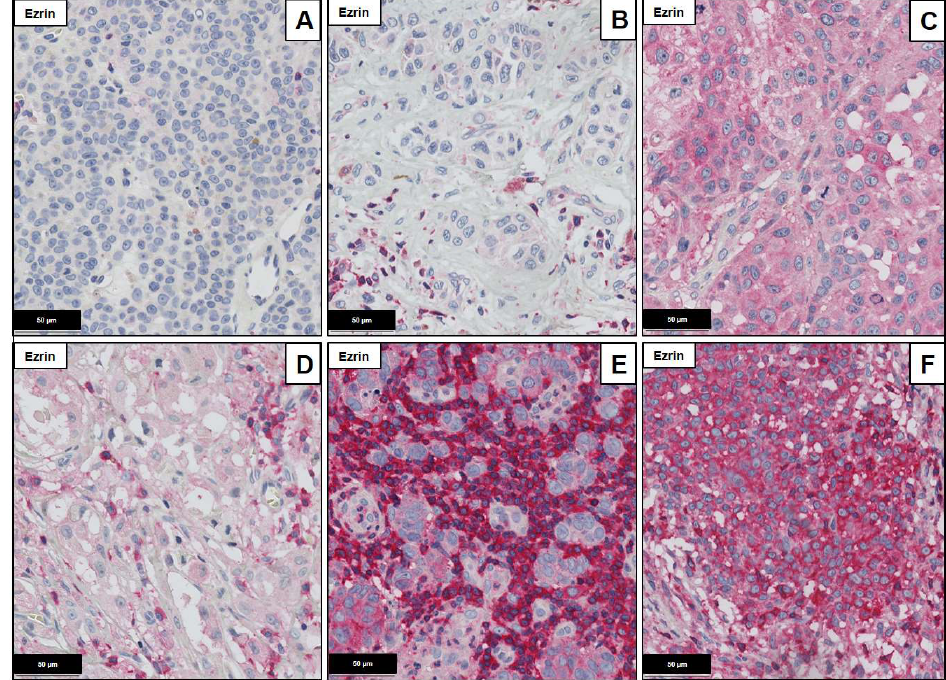
Figure 4. Ezrin staining, magnification 40×. ( A ) Absence of staining (GIS-score 0). ( B ) Weak positivity in <10% (GIS-score 1). ( C ) Weak positivity in 50–90% of tumor cells (GIS-score 3). ( D ) Moderate positivity in <10% of tumor cells (GIS-score 2). ( E ) Moderate positivity in 10–50% of tumor cells (GIS-Score 4). ( F ) Moderate positivity in >90% of tumor cells (GIS-Score 8).